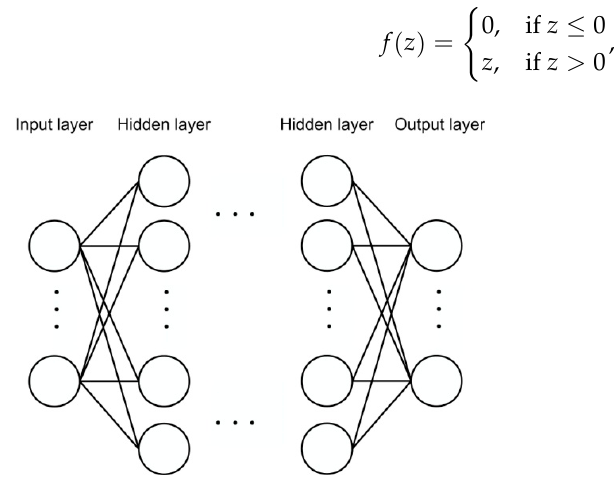
Figure 3. The architecture of a stacked deep neural networks.